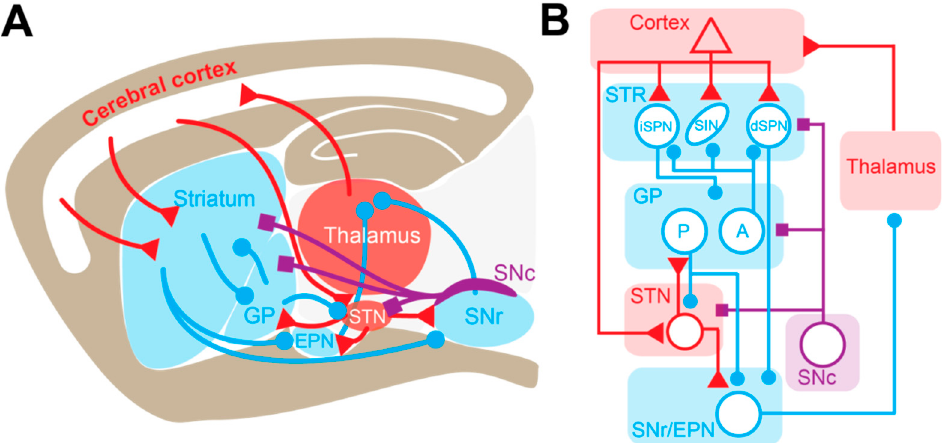
Figure 1. Basal ganglia circuitry in rodents. ( A ) Schematic representing the main connections of the basal ganglia network in a sagittal section of the rodent brain. ( B ) Corresponding anatomical-functional diagram adapted from the Albin model of the basal ganglia [8]. Dopaminergic, GABAergic, and glutamatergic projections and nuclei are depicted in blue, purple and red, respectively. A: arkypallidal neuron; dSPN: direct-pathway spiny projection neuron; EPN: entopedoncular nucleus; GP: globus pallidus; iSPN: indirect-pathway spiny projection neuron; P: prototypic neuron; SNc: substantia nigra pars compacta; SNr: Substantia nigra pars reticulata; SIN: Striatal interneurons; STN: subthalamic nucleus.